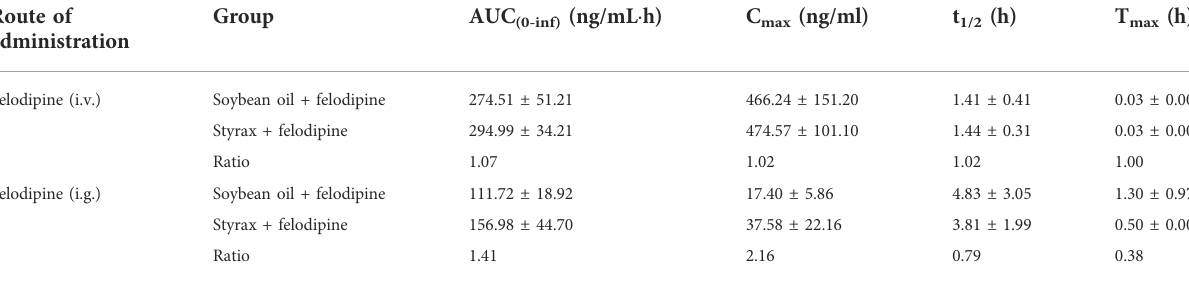
TABLE 2 Pharmacokinetic parameters of felodipine after administrating felodipine (i.v., 2 mg/kg; i.g., 10 mg/kg) in rats pretreated with Soybean oil, Styrax (100 mg/kg). Data are the mean ± SD. Route of